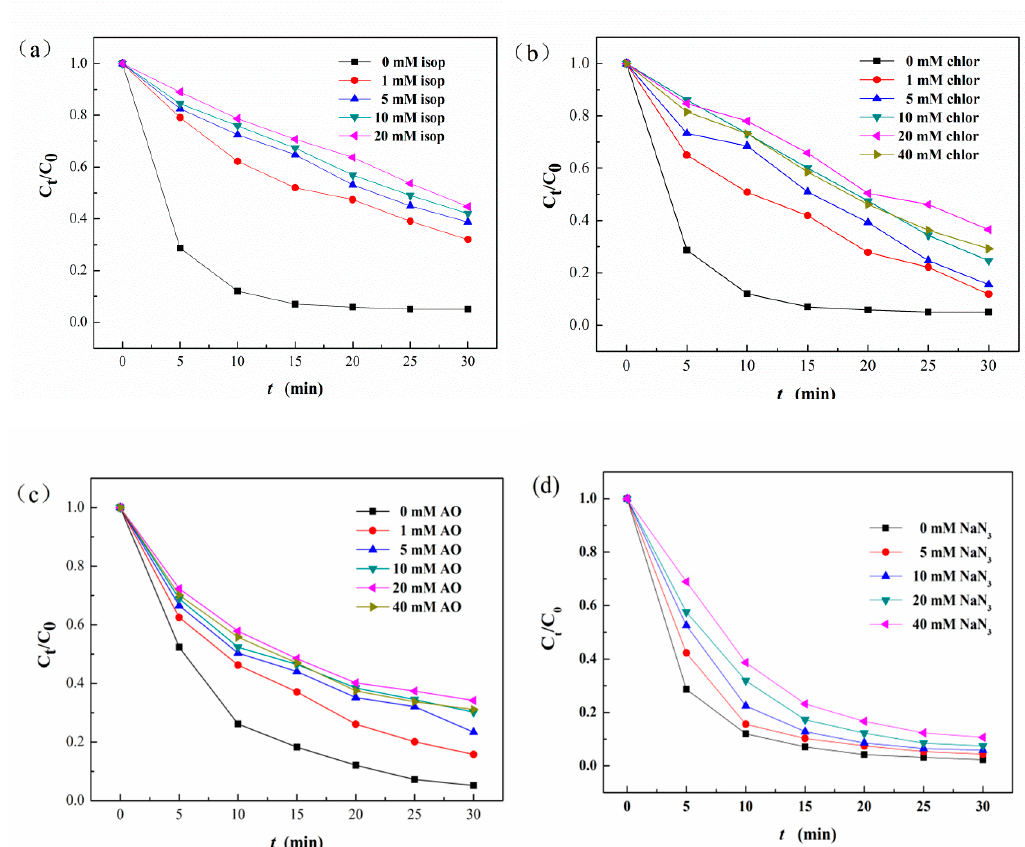
Figure 14. The influence of ammonium oxalate ( a ), chloroform ( b ) isopropyl alcohol ( c ) and sodium azide ( d ) on the MB decolorization efficiency. (pH = 7; [MB] = 10 mg/L; [H 2 O 2 ] = 10 mM; catalyst dosage = 1.0 g/L; radiation intensity = 500 W).